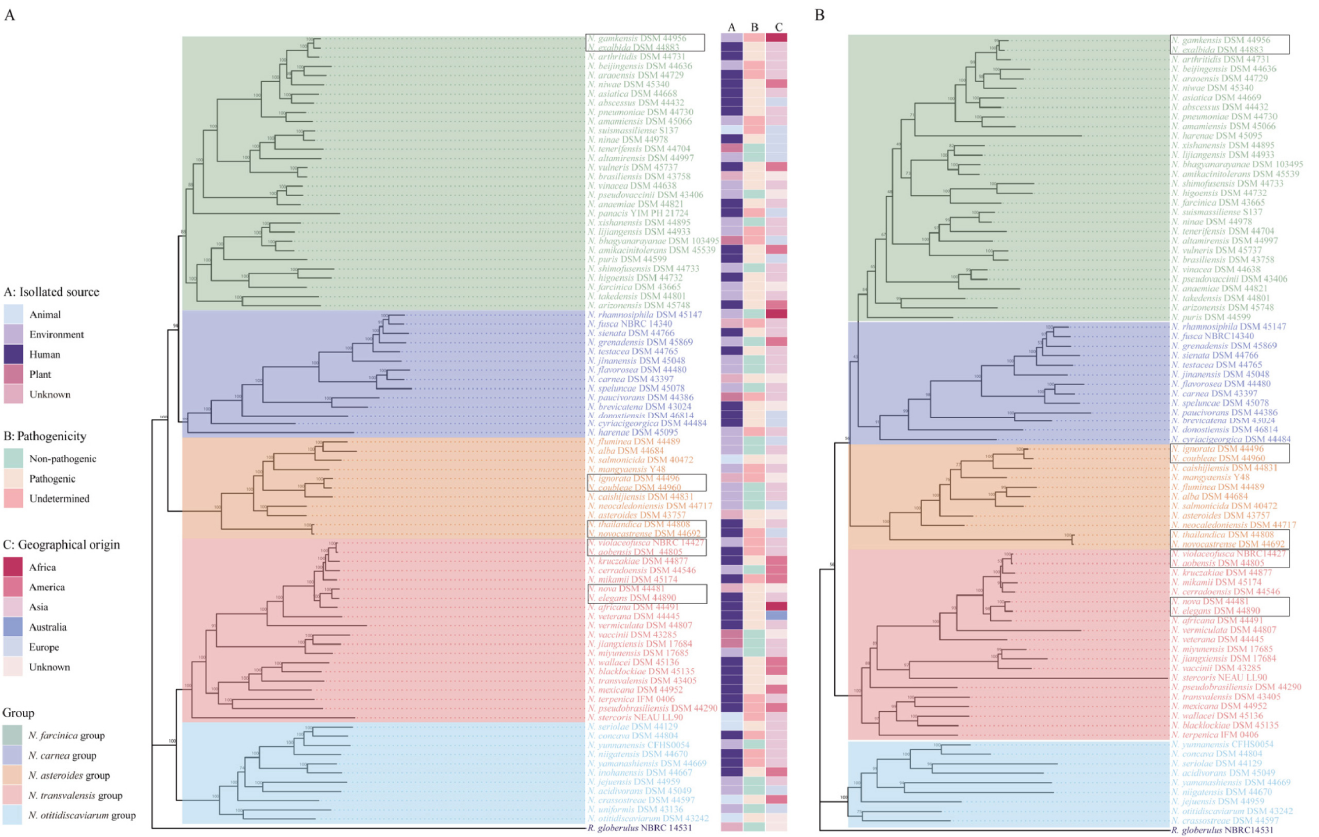
Fig 2. Phylogenomic and phylogenetic trees of the type strains of Nocardia . (A) A phylogenomic tree was constructed based on the concatenation of 384 single-copy genes from 86 type strains. The isolated source, pathogenicity, and geographical origin are shown. (B) Phylogenetic tree based on the single gene dapb1 from 86 type strains. Each tree was constructed by the maximum likelihood method with 1000 bootstrap replicates. Rhodococcus globerulus NBRC 14531 served as an outgroup. Bootstrap values are indicated on the nodes. The colored branches indicate the five main phylogenetic groups. Black boxes indicate synonymous